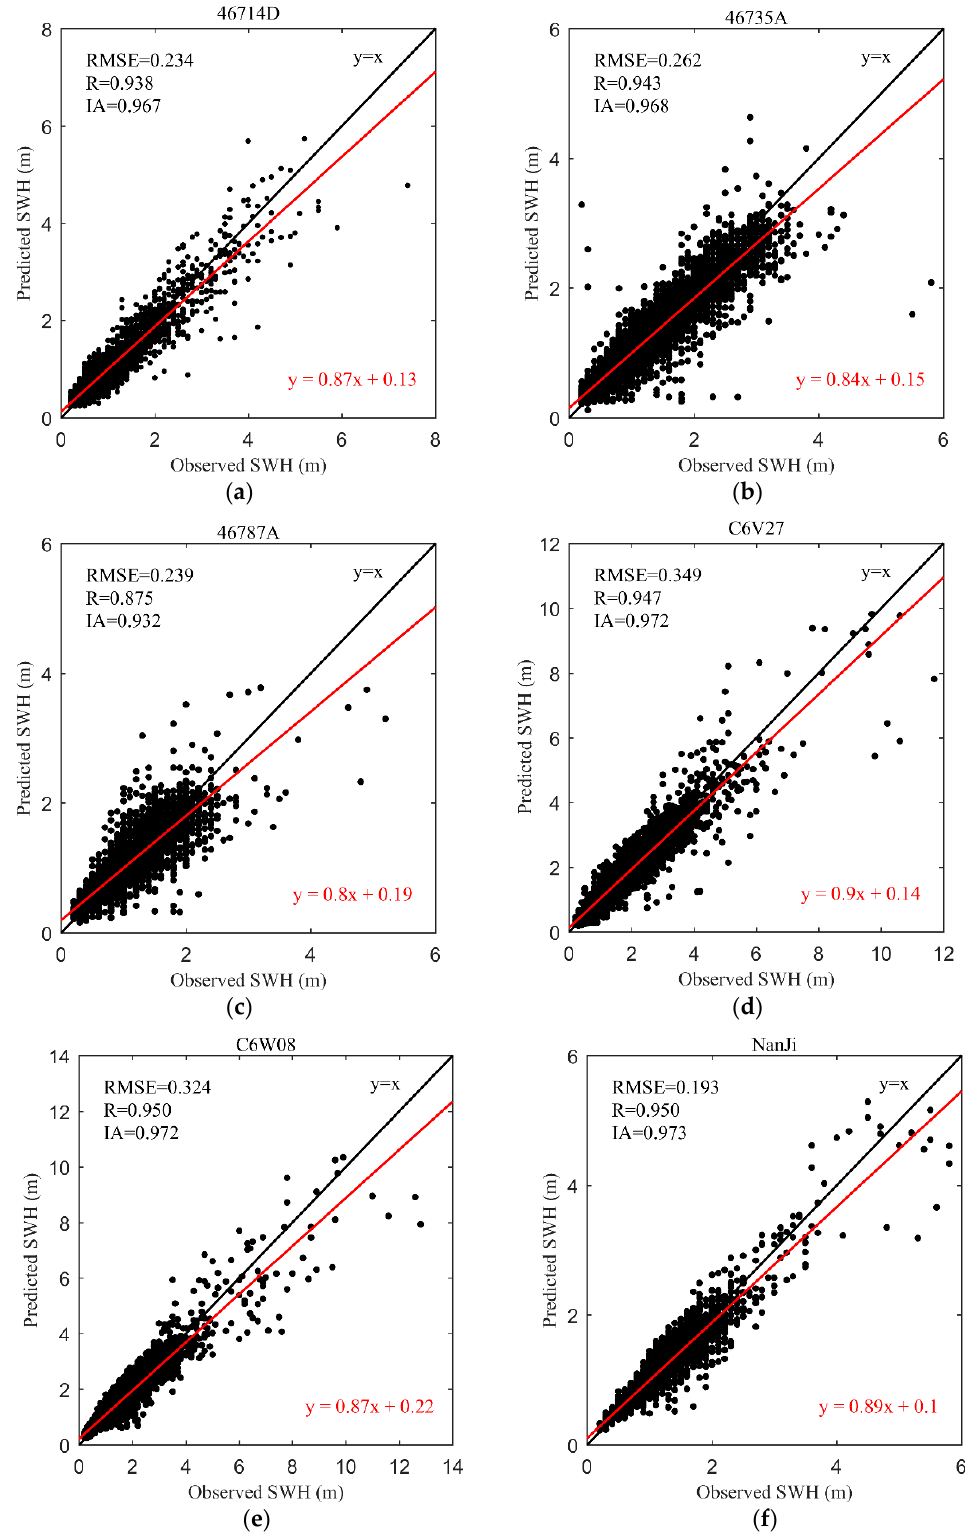
Figure 3. Scatter diagram for 3 hourly forecasting based on GRU at various stations: (a) station 46714D, (b) station 46735A, (c) station 46787A, (d) station C6V27, (e) station C6W08, (f) station NanJi. As can be seen from Figure 3, the observed and predicted values produced by GRU have a considerable accordance for 3 hourly prediction. Especially at Station C6V27, the predicted SWH correlated very well with the observed values. Even so, what cannot be ignored is that there are some outliers that are not concentrated near the bisector. The most likely cause is that the vast majority of SWH observed at these stations are less than 4 m, whereas a few extreme events still exist. To reveal the difference in prediction performance between GRU and the other four methods clearly, we randomly choose a piece of the predictive results for each station to show in Figure 4, in which the number of data points is 100. ( a )